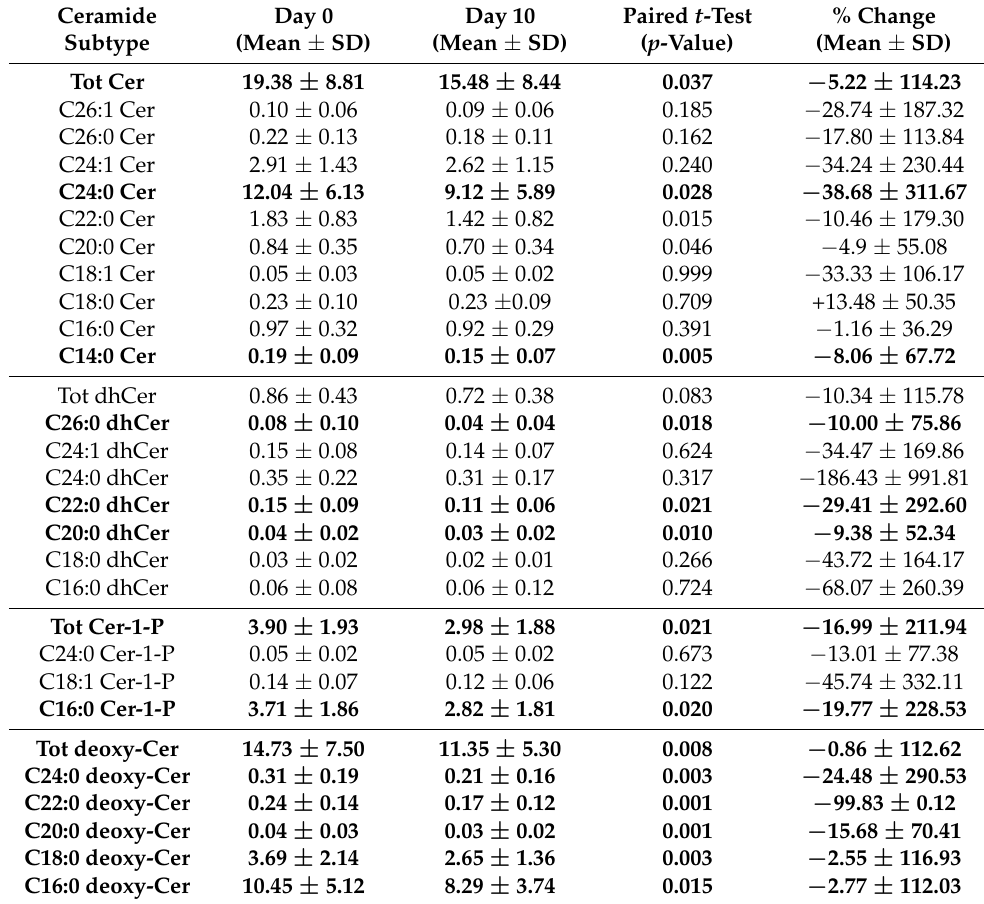
Table 1. Ceramide levels by totals and subtypes ( n =